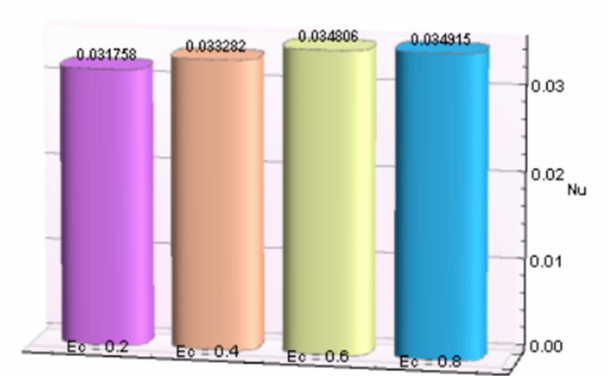
Figure 22. λ verses Nu .